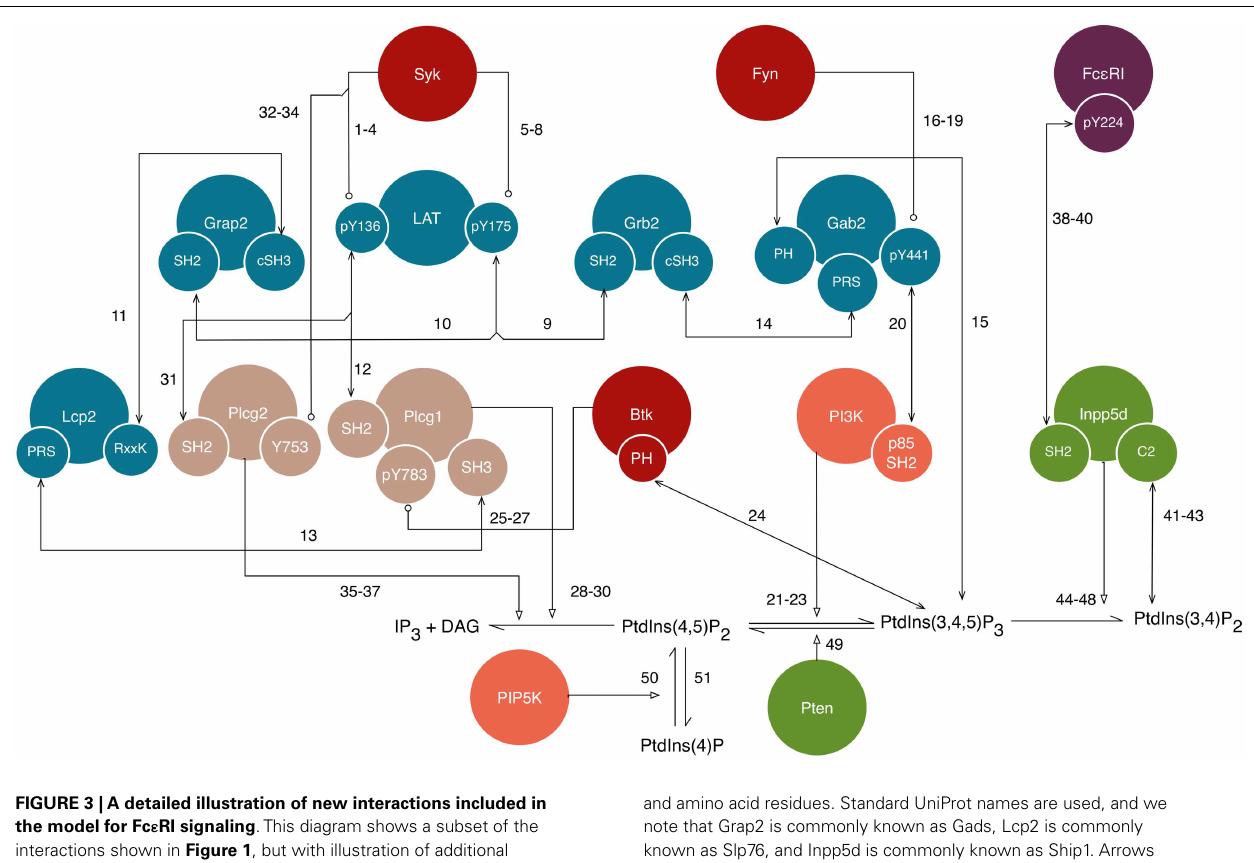
color-coding and arrow symbols are the same as in Figure 1 . Large circles represent proteins. Small circles, overlapping the edges of large circles, represent protein sites/components, such as domains,